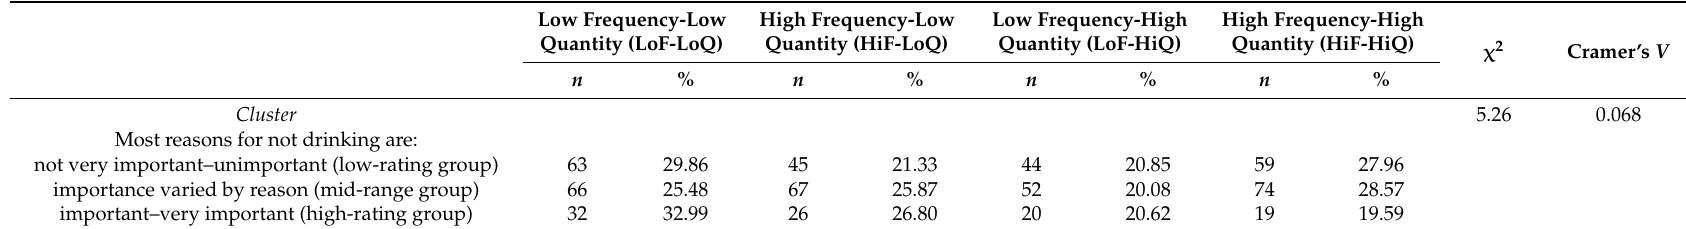
Table 7. Reasons for not drinking by drinking